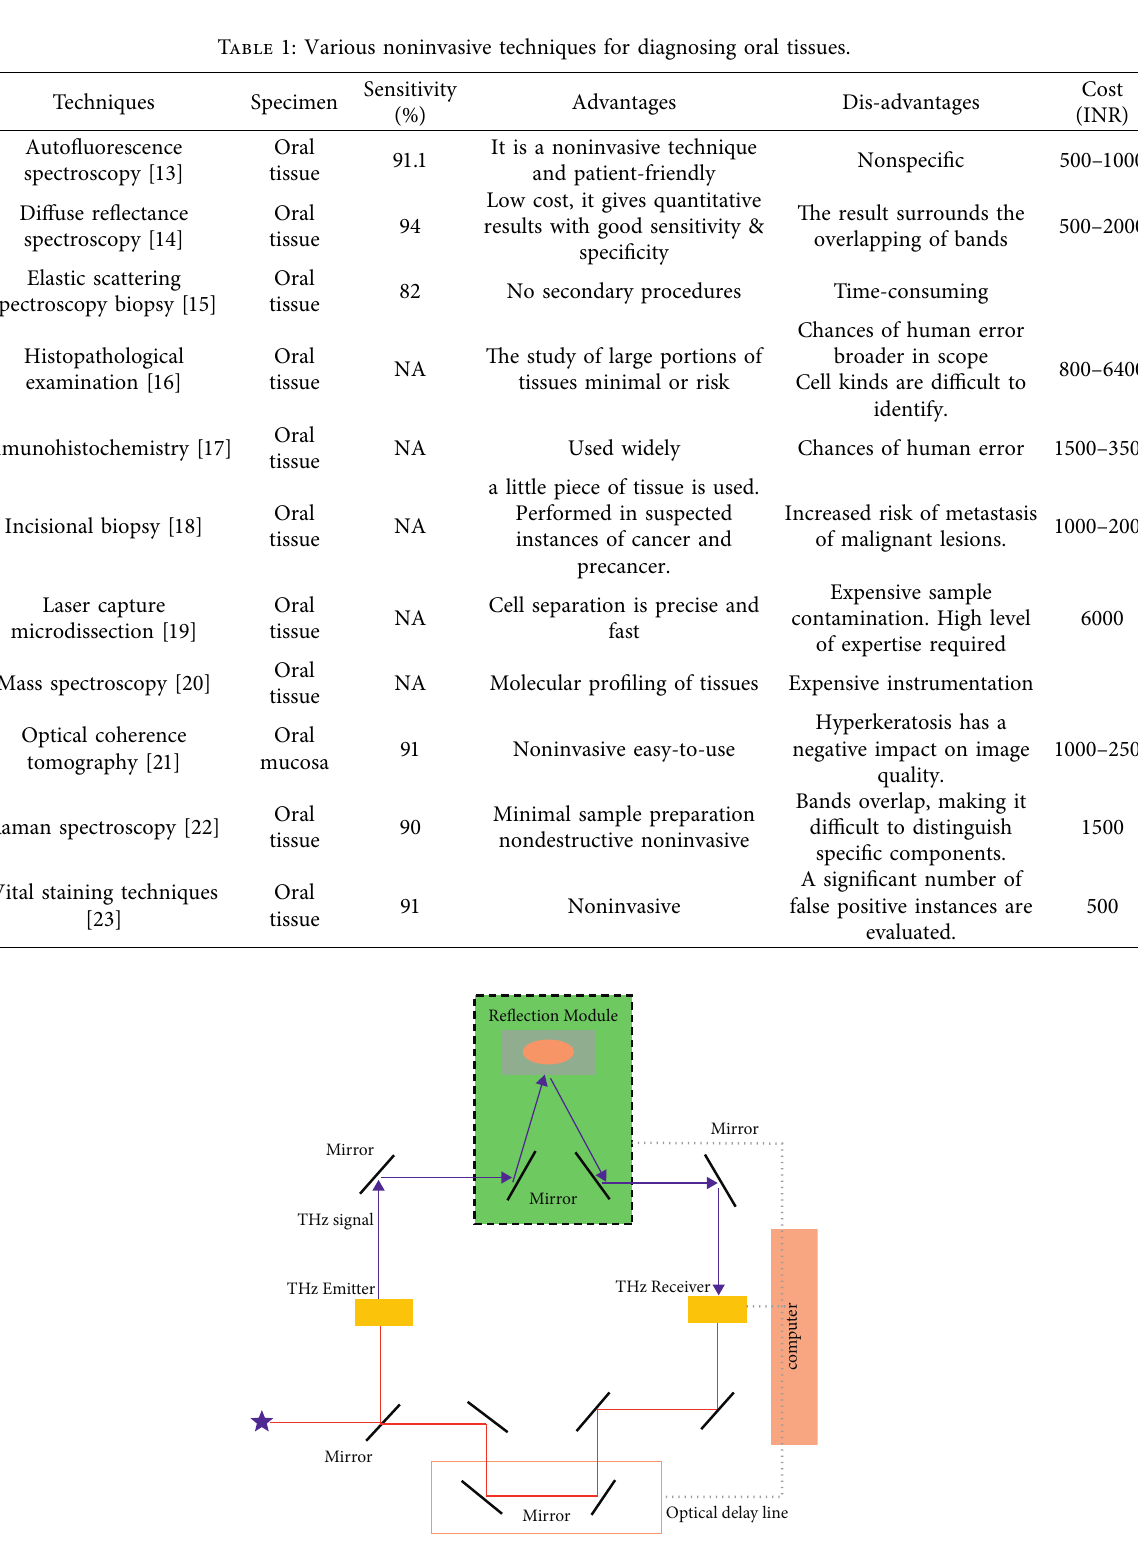
Figure 1: Typical experimental set-up of THz-TDS (reflection